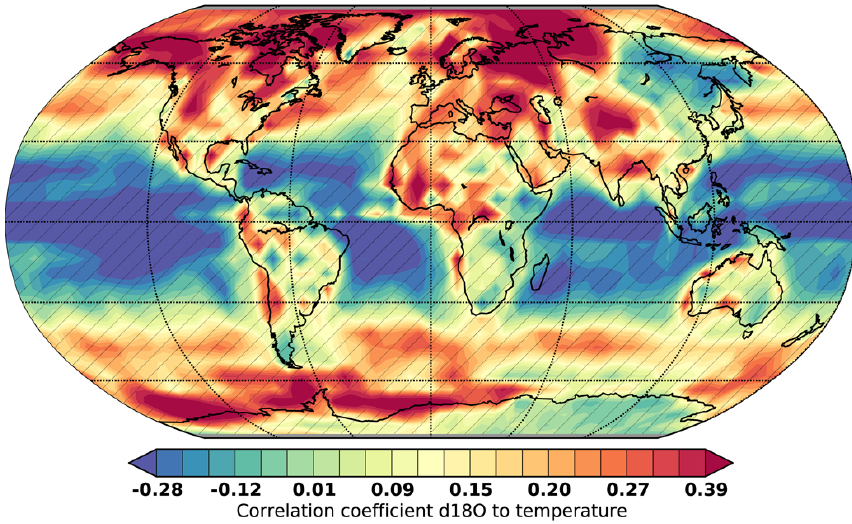
Fig. 7. Spatio-temporal correlation between δ 18 O in precipitation and temperature within i LOVECLIM. Figure is constructed from monthly mean data. Hatching indicates areas where correlation is poor ( <